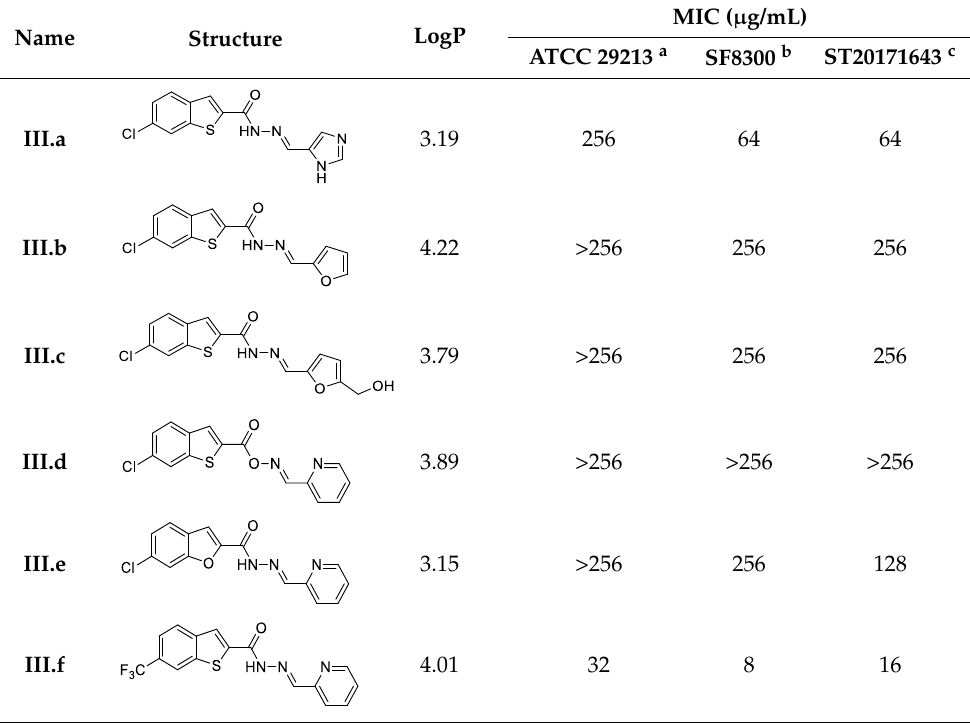
Table 3. Minimum inhibitory concentrations of set III molecules against S. aureus strains.